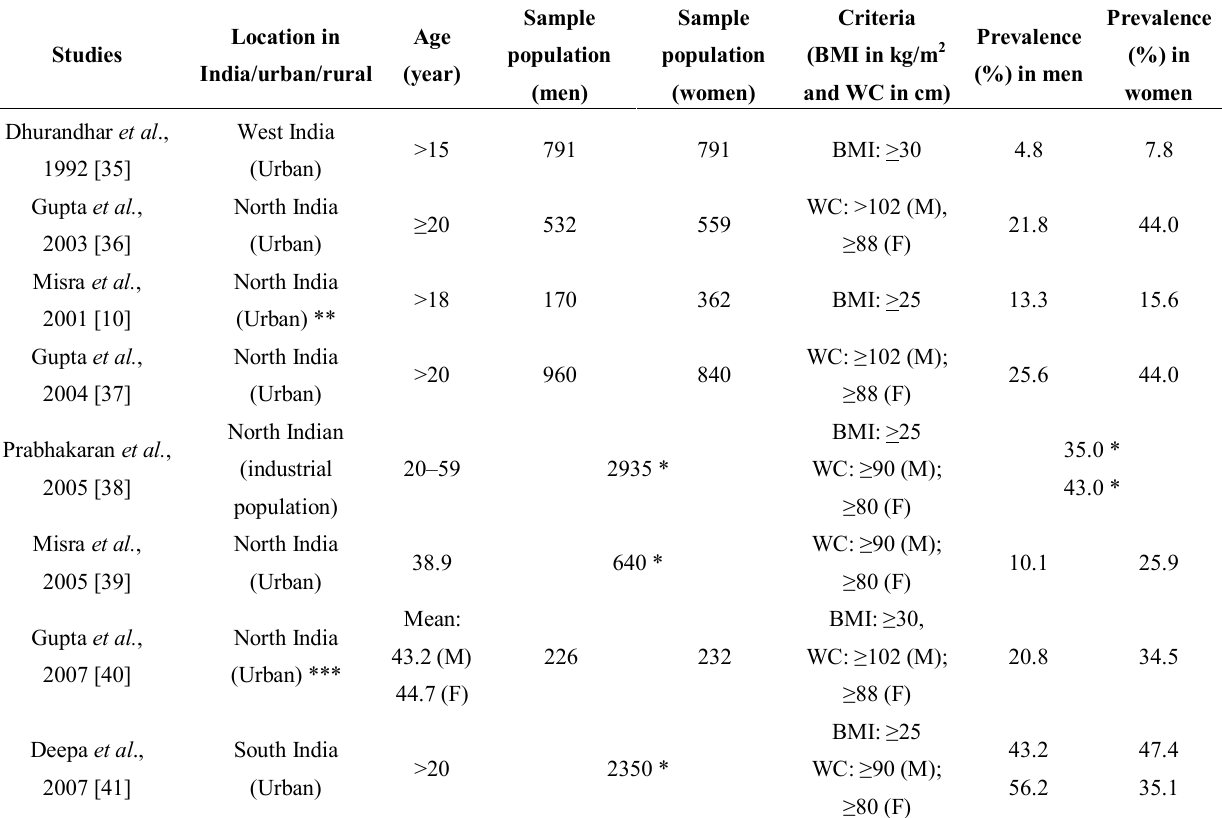
Table 2. Prevalence of obesity in South